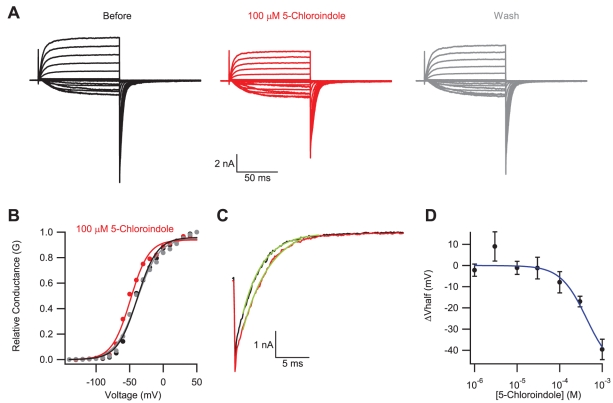
5-Chloroindole modulated currents from EAG1 channels.Current traces (A) and conductance-voltage relationship (B) for EAG1 channels recorded in the inside-out patch configuration in the absence (black), presence (red) and after washout (grey) of 100 µM 5-chloroindole. (C) The tail current at −120 mV, following a voltage step to −50 mV, in the absence (black) and presence (red) of 100 µM 5-chloroindole, and fit with single exponentials to give time constants of 3.0 ms before, and 4.1 ms after application of 5-chloroindole. (D) Plot of the change in the Vhalf versus 5-chloroindole concentration, fit with a Hill equation. The binding affinity and Hill coefficient of 5-chloroindole were 420 µM and 1.4 respectively.